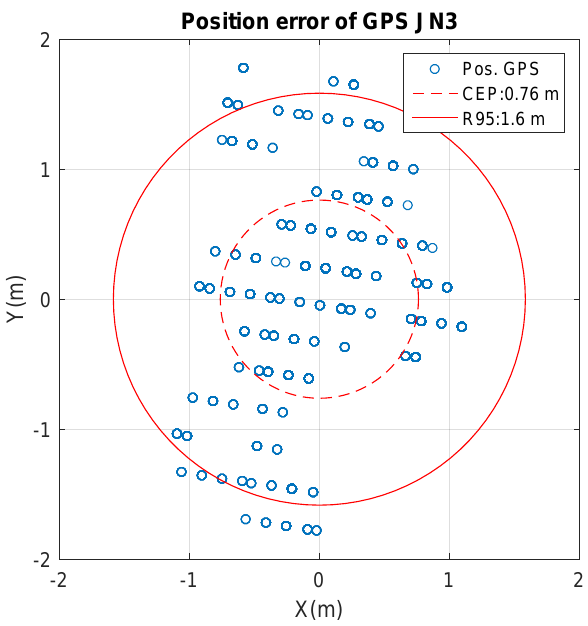
Figure 18. Static position errors on the x and y axes of the JN3